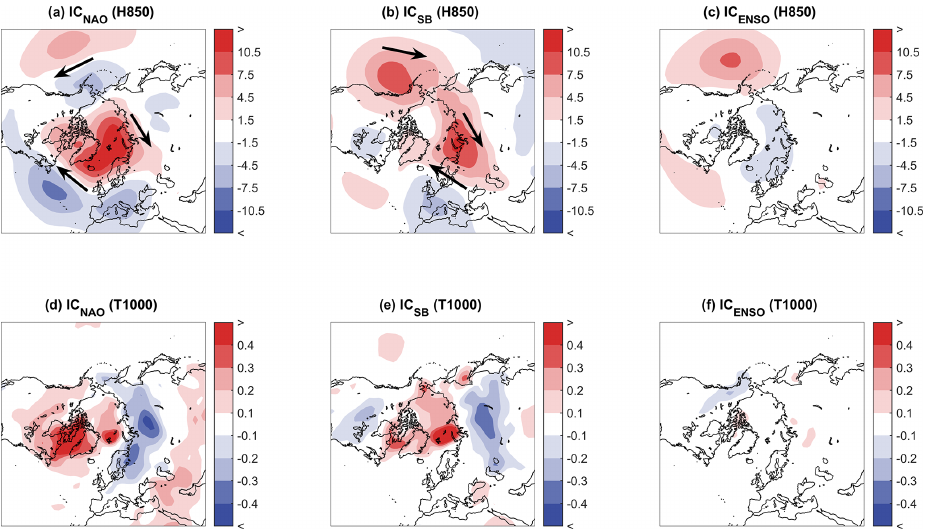
Figure 1. Winter trends (1980–2015) of geopotential height at 850mbar (H850, myr − 1 , a–c ) and near-surface temperature at 1000mbar (T1000 Kyr − 1 , d–f ) of the independent atmospheric patterns related to the North Atlantic Oscillation (IC NAO ) , Scandinavian Blocking (IC SB ) and El Niño–Southern Oscillation (IC ENSO ) . The arrows provide a qualitative representation of the circulation paths tendencies associated with the (a) IC NAO and (b) IC SB independent component